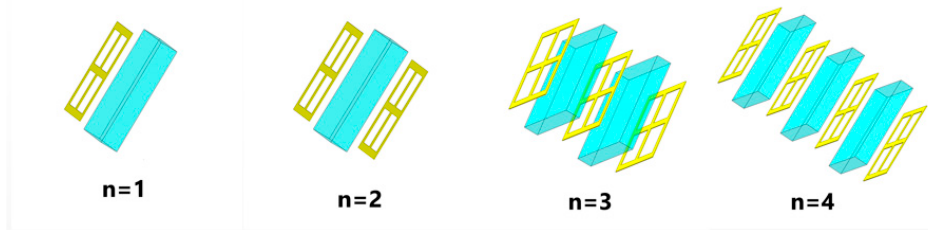
Figure 4. Structure with different number of metal layers.